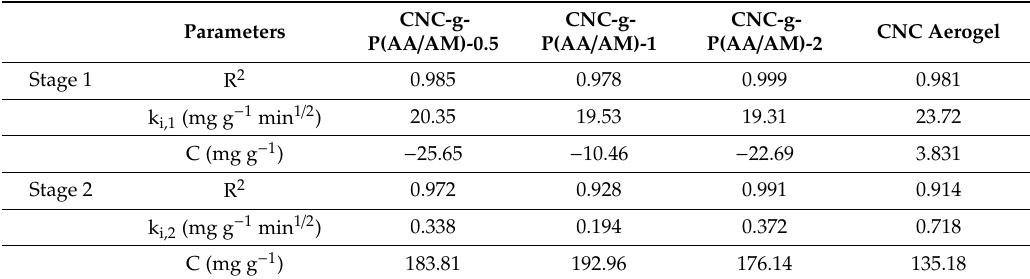
Table 2. Kinetic parameters of the intra-particle di ff usion model.